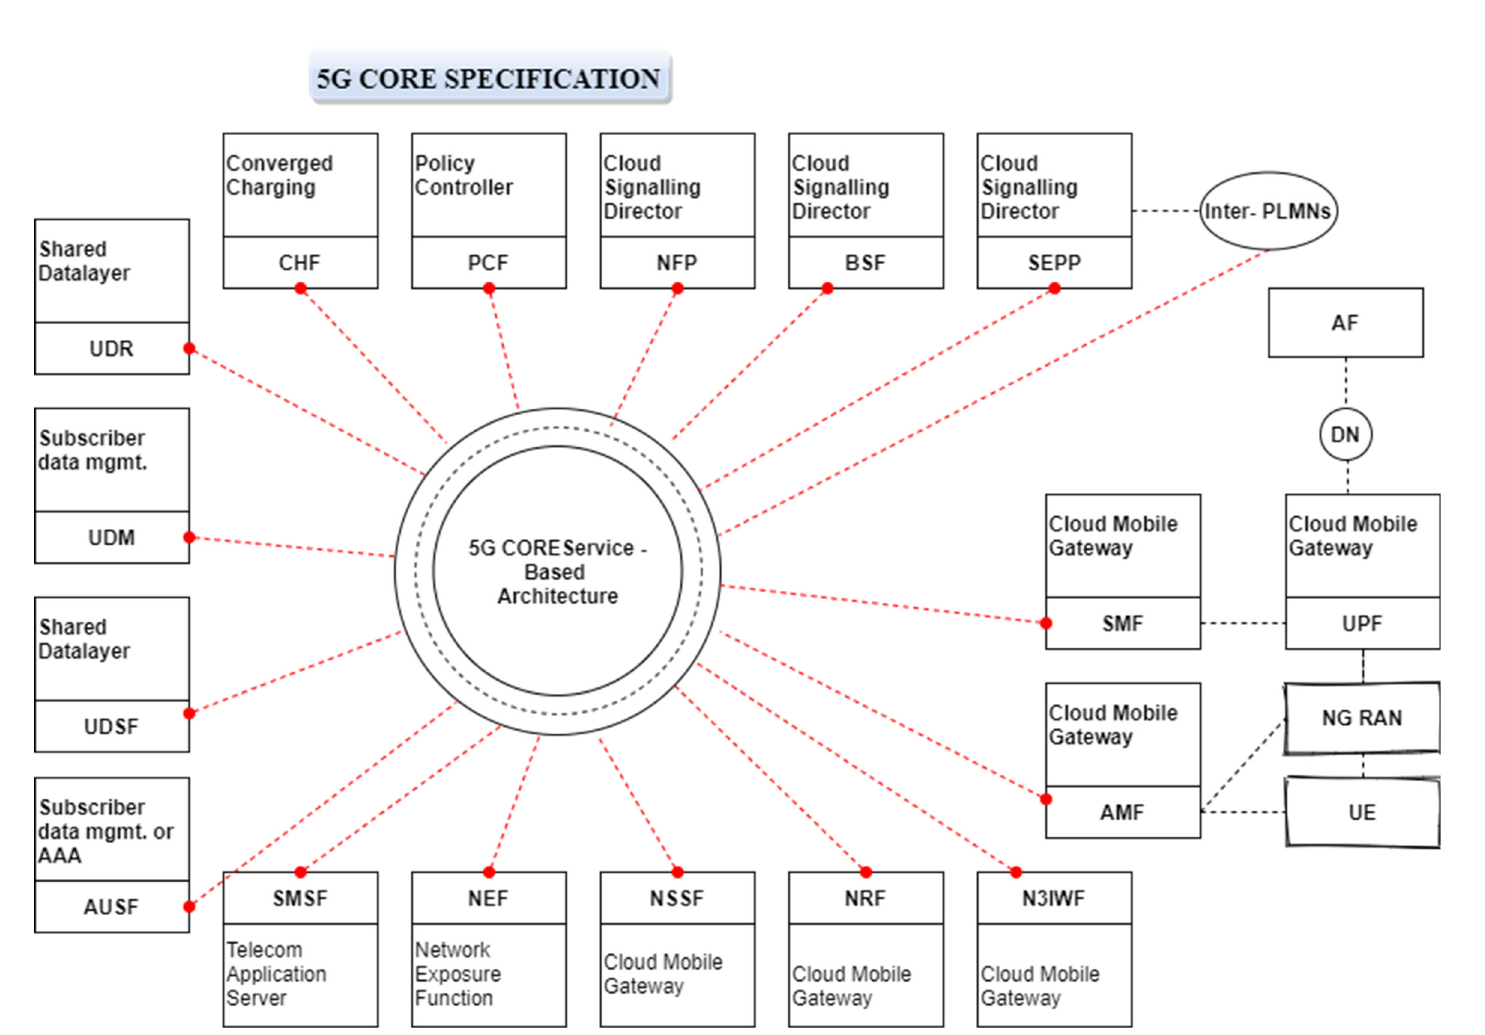
Figure 3. 5G − CORE speci fi cation for dynamic spectrum sharing.